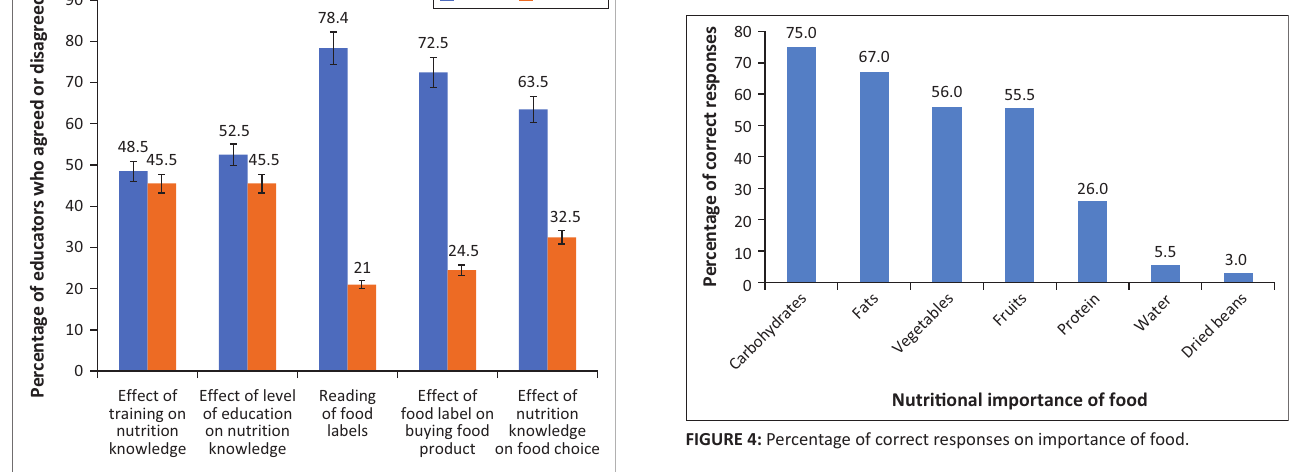
FIGURE 3: A radar chart showing the percentage of educators’ behaviours related to food choices.